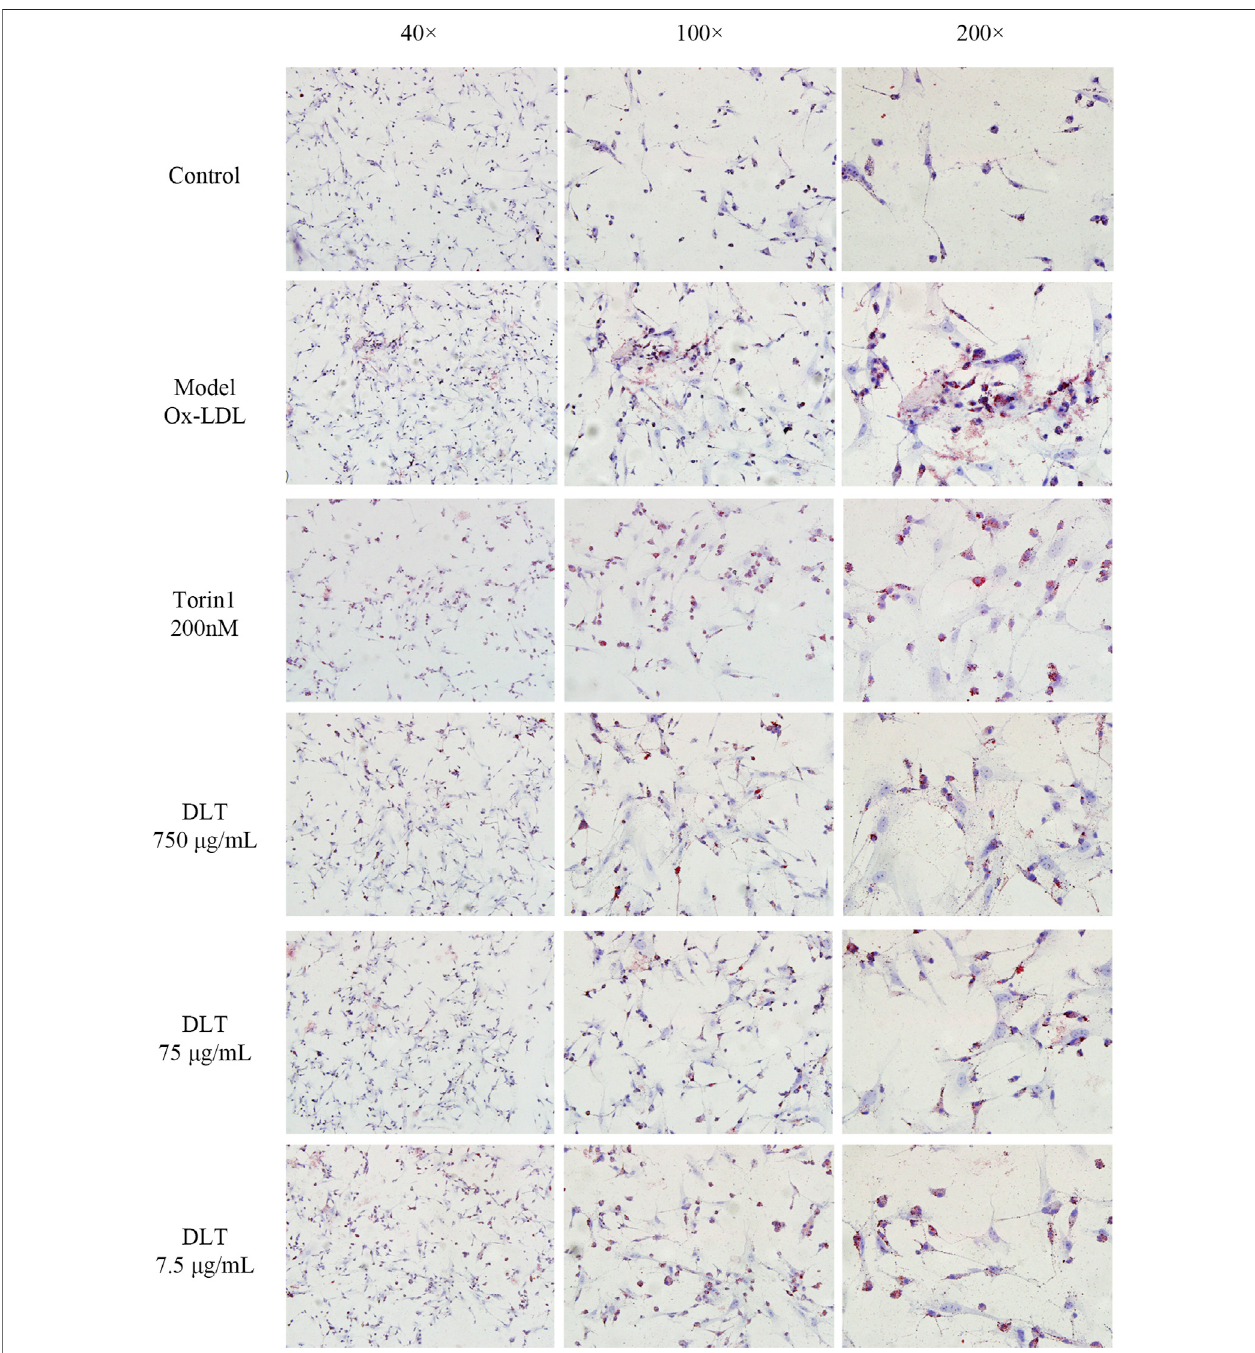
FIGURE 8 | DLTs reduced the accumulation of intracellular lipids in BMDMs. Representative images of oil red O staining are presented (magni fi cation × 40, × 100, × 200). Ox-LDL-induced BMDM group showed more red lipid droplets, while the Torin 1 group and the DLT groups exhibited less red lipid droplets.